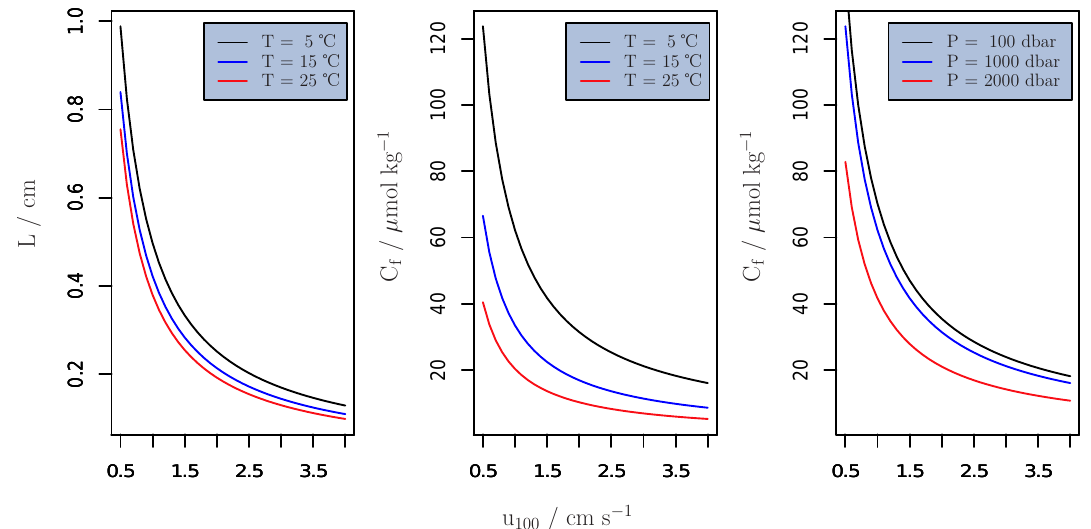
Fig. 4. The influence of flow velocity u 100 , temperature T and hydrostatic pressure P on the DBL thickness L and C f , the minimal oxygen concentration supporting a given laboratory-determined oxygen uptake rate E . The dependency of L (and all derived quan- tities) on u 100 is based on the simple exemplary model description employed here. While individual organism-specific dependencies may vary in detail, the general dependency of L on the flow velocity is captured here. For all calculations we assume a generic con- stant value of E = 20 × 10 − 7 µmols − 1 cm − 2 . Unless stated otherwise in the legend, latitude=29.5 ◦ N, S = 34, T =5 ◦ C, P = 100bar, E = 20 × 10 − 7 µmols − 1 cm − 2 , T E =5 ◦ C, and S E =34.